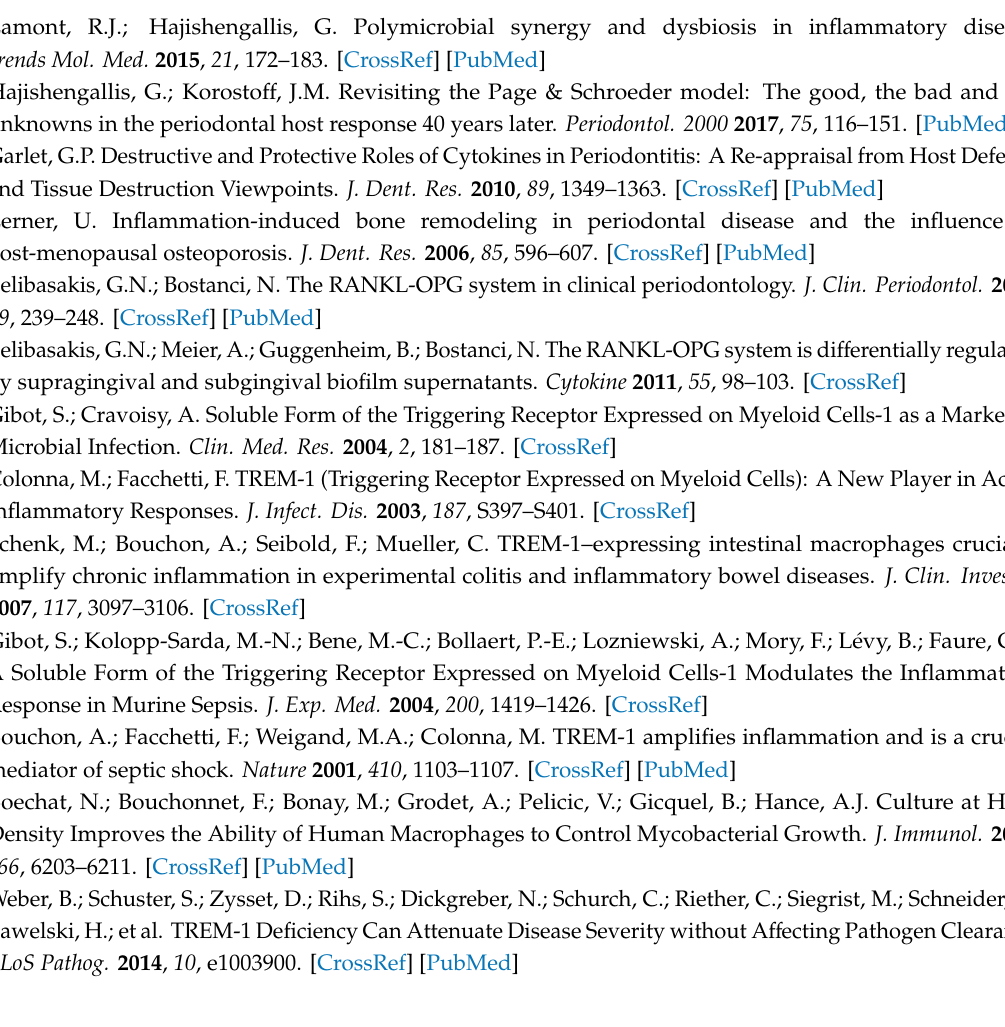
Table S1: Immune gene expression profile in ligated gingiva vs healthy gingiva, Table S2: immune regulatory genes in mouse gingiva by